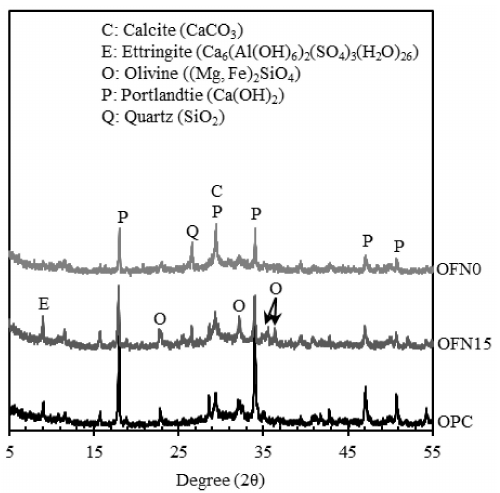
Figure 3. XRD curve of paste for 365 days of